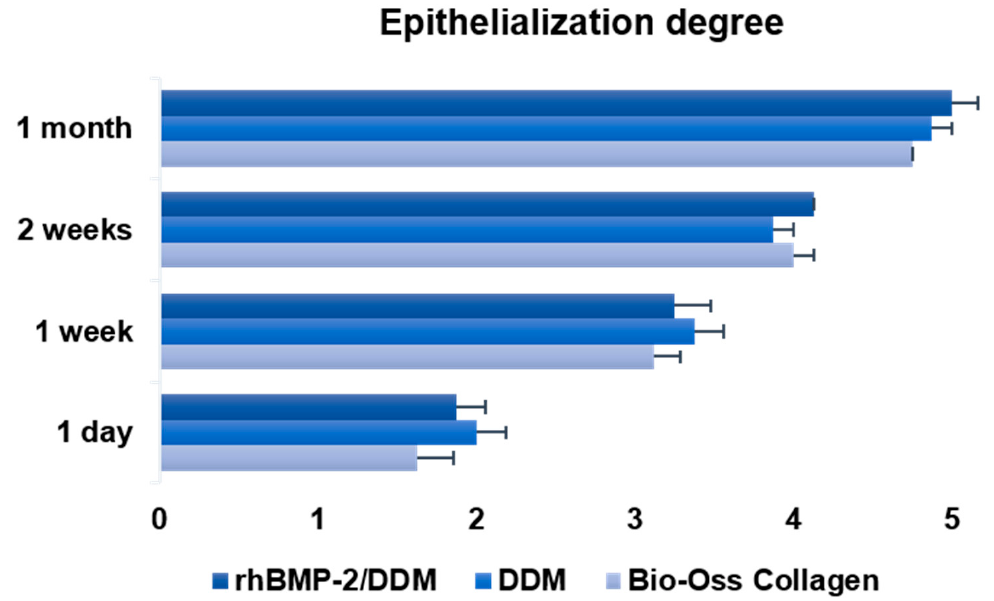
Figure 7. Degree of epithelialization.